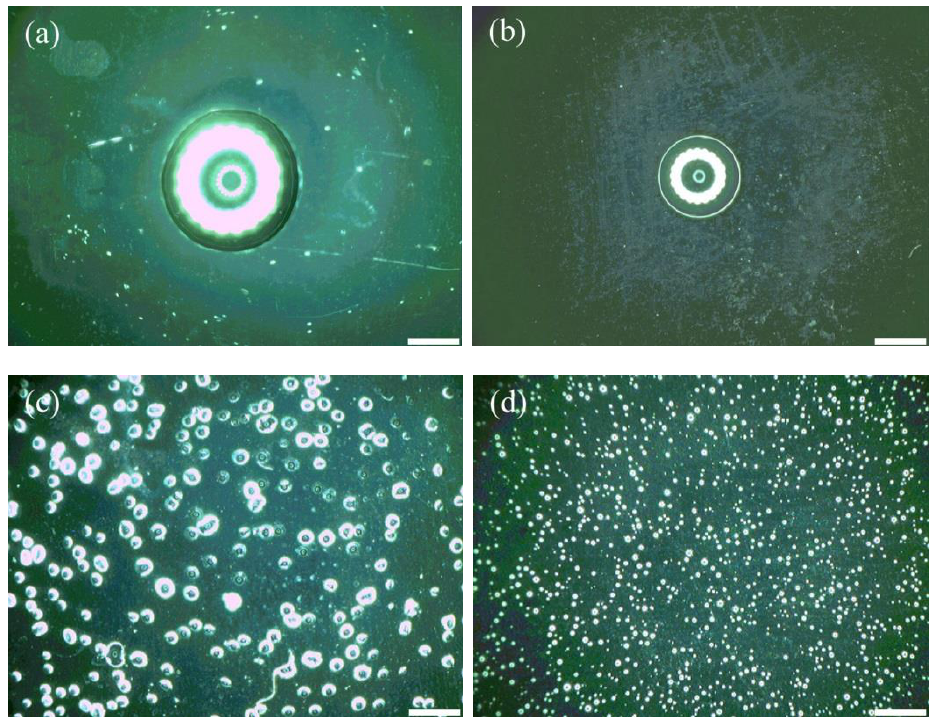
Figure 4. Representative top view images of 2 µ L water droplet and sprayed water film on ( a , c ) glass and ( b , d ) film sample S5.8, respectively (bar = 1 mm).